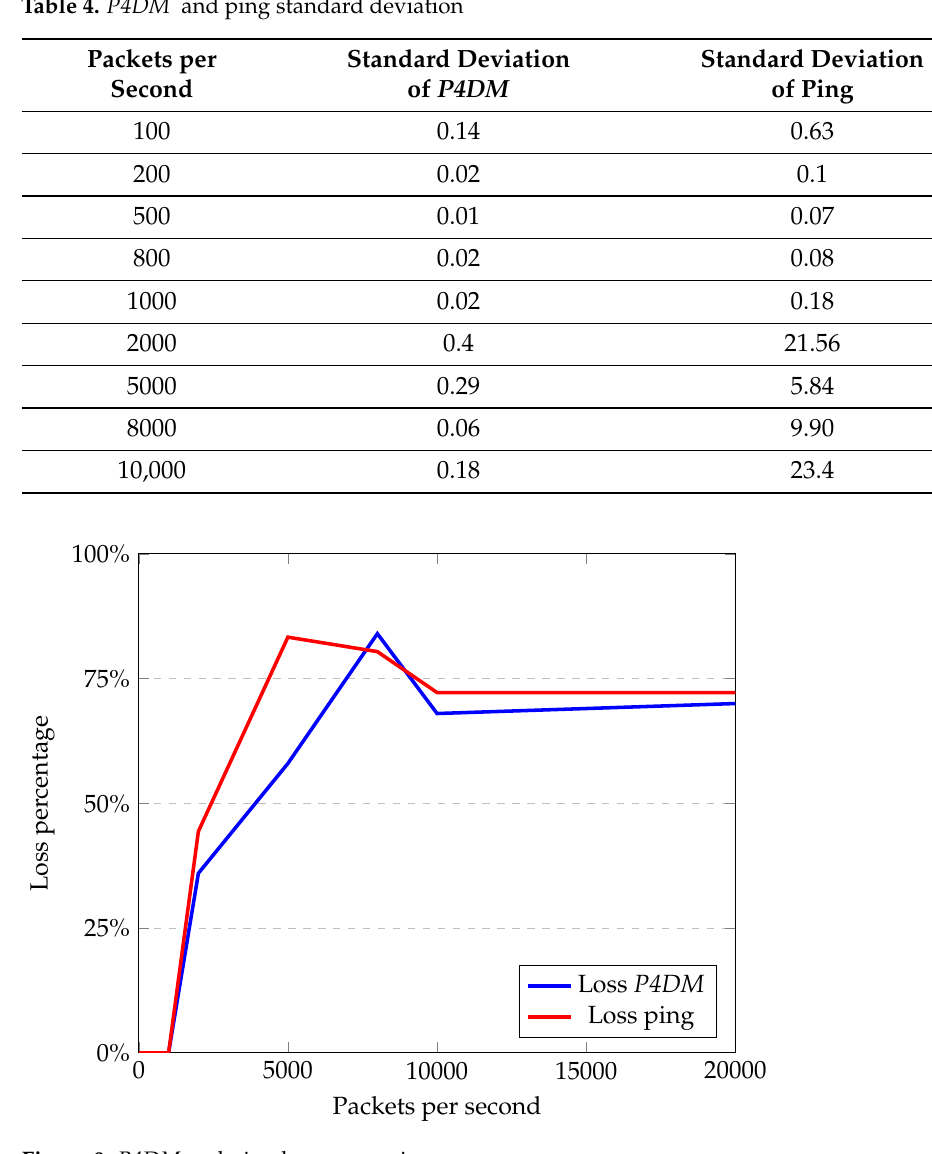
Figure 9. P4DM and ping loss